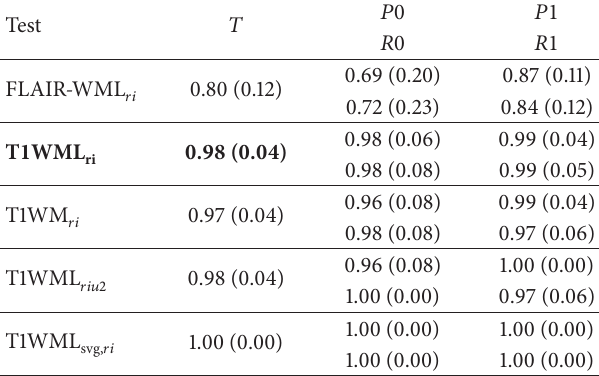
Table 3: Results are reported as mean with standard deviation in brackets, 𝑚 ( 𝑠 ), over 10-fold cross validation, classifying NC versus AD + LBD. 𝑇 = total accuracy, 𝑅 = recall, and 𝑃 = precision. 0 for class NC and 1 for class AD + LBD. ROI is either WM for white matter or WML for white matter lesion